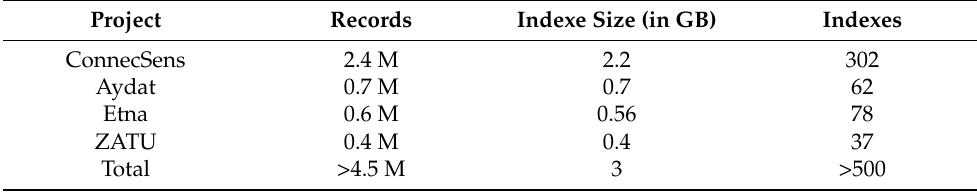
Table 2. Table describing the number of records and the size in elastic